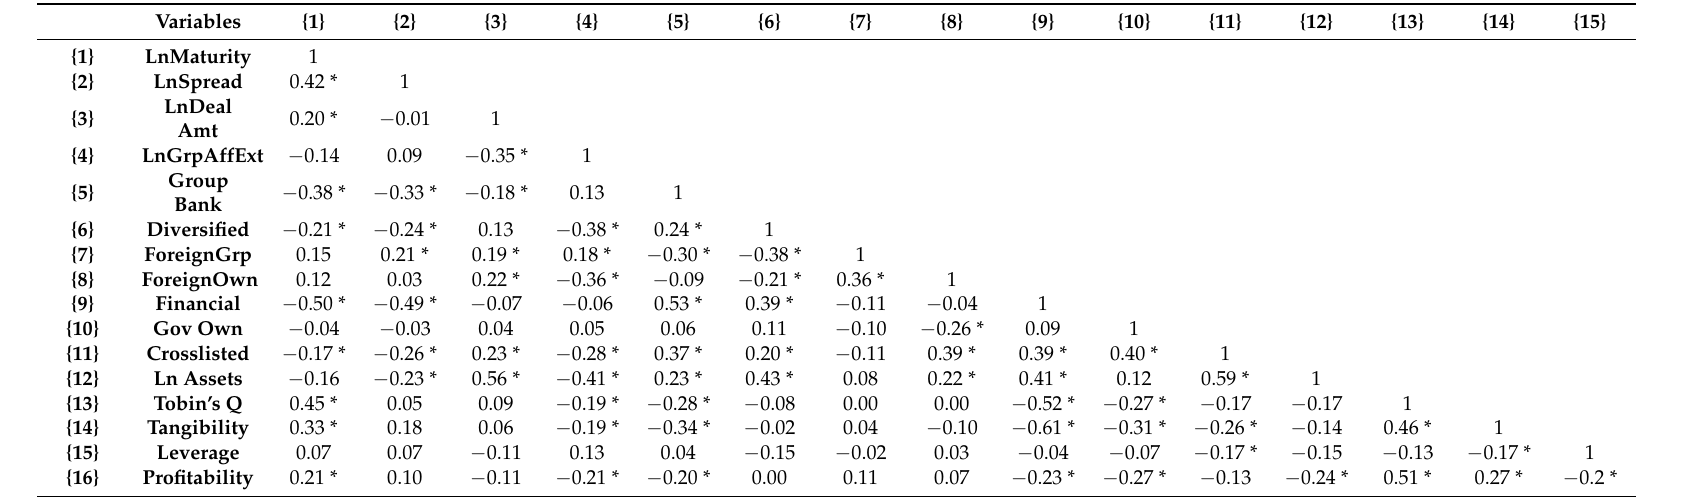
Table 2. Correlation matrix. Table 2 displays all pairwise correlation coefficients of the variables used in the analysis with the Bonferroni adjustment to calculated significance levels. The definitions of the variables remain the same as in Table 1. All the correlation coefficients with a Bonferroni-adjusted significance level of 5% or better are